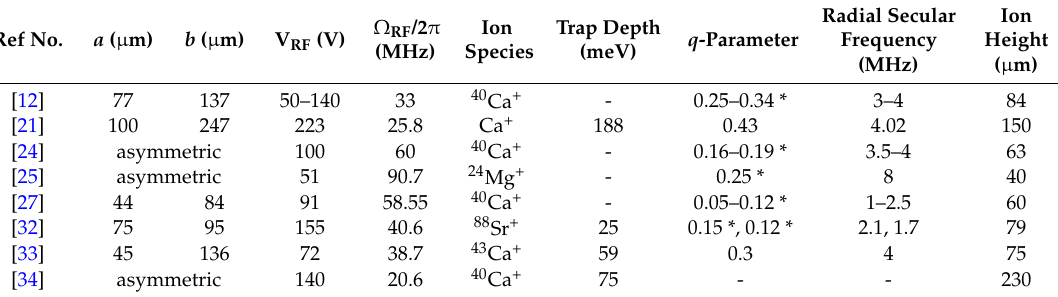
Table 1. Electrode dimensions and specifications of surface ion traps.